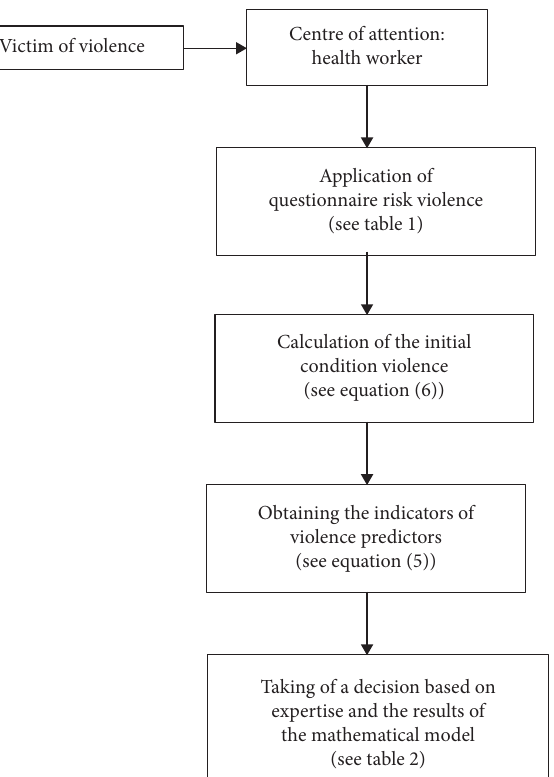
Figure 5: Flow diagram to help the health workers in the prediction of the levels of